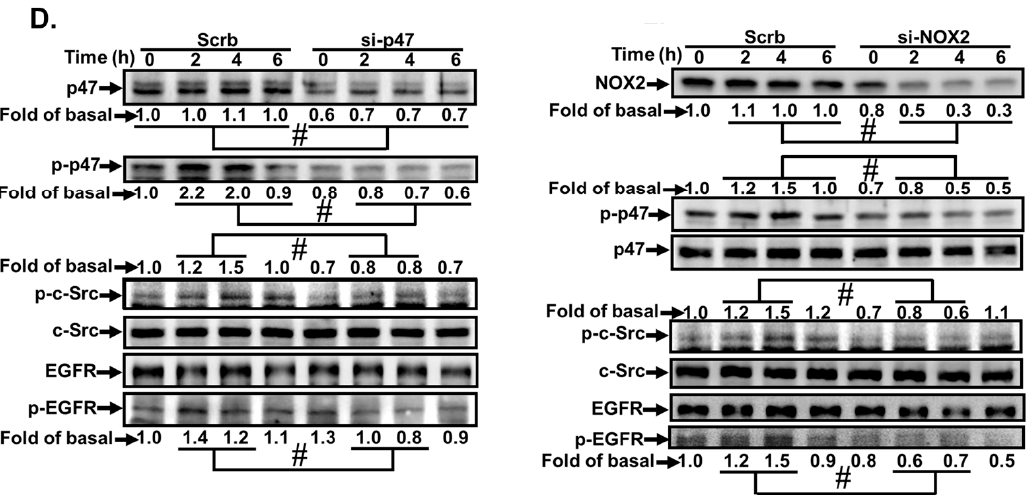
Figure 4. CORM-2 induces the formation of a c-Src/EGFR/p47 phox /Nox2 complex. ( A ) HPAEpiCs were transfected with scrambled, p47 phox , or Nox2 siRNA and then incubated with CORM-2 for 16 h. The levels of p47 phox , Nox2, HO-1, and β -actin protein were determined by western blot. ( B , C ) Cells were treated with CORM-2 for the indicated time intervals. The cell lysates were subjected to immunoprecipitation using an anti-Nox2 or anti-EGFR antibody. The immunoprecipitates were analyzed by western blot using an anti-c-Src, anti-EGFR, anti-Nox2, or anti-p47 phox antibody. ( D ) HPAEpiCs were transfected with scrambled, p47 phox , or Nox2 siRNA and then incubated with CORM-2 for the indicated time intervals. The levels of p47 phox , c-Src, and EGFR phosphorylation were determined by western blot. Data are representative of three independent experiments ( n = 3). # p < 0.01, as compared with the respective values of cells stimulated with CORM2 alone or compared between the indicated groups.